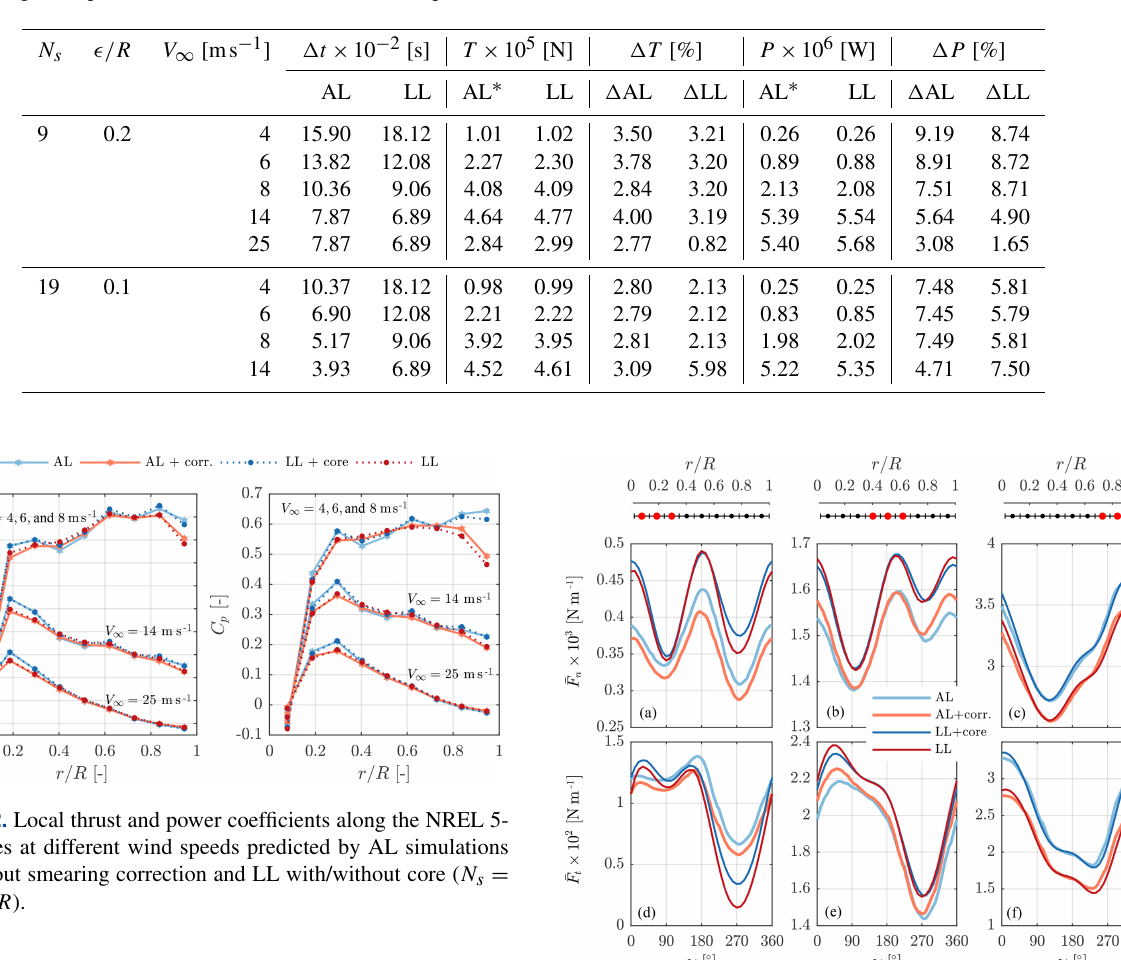
Table 3. An overview of the simulation inputs and results for the NREL 5-MW in uniform inflow. Results are grouped by blade/grid resolution. For the actuator line (AL) and lifting line (LL) the simulation time step (cid:49)t , the total thrust T and power P as well as the relative change in these quantities caused by the correction/removing the viscous core are listed. Note that AL ∗ represents the corrected AL results, and the change is expressed relative to the rotor thrust and power.